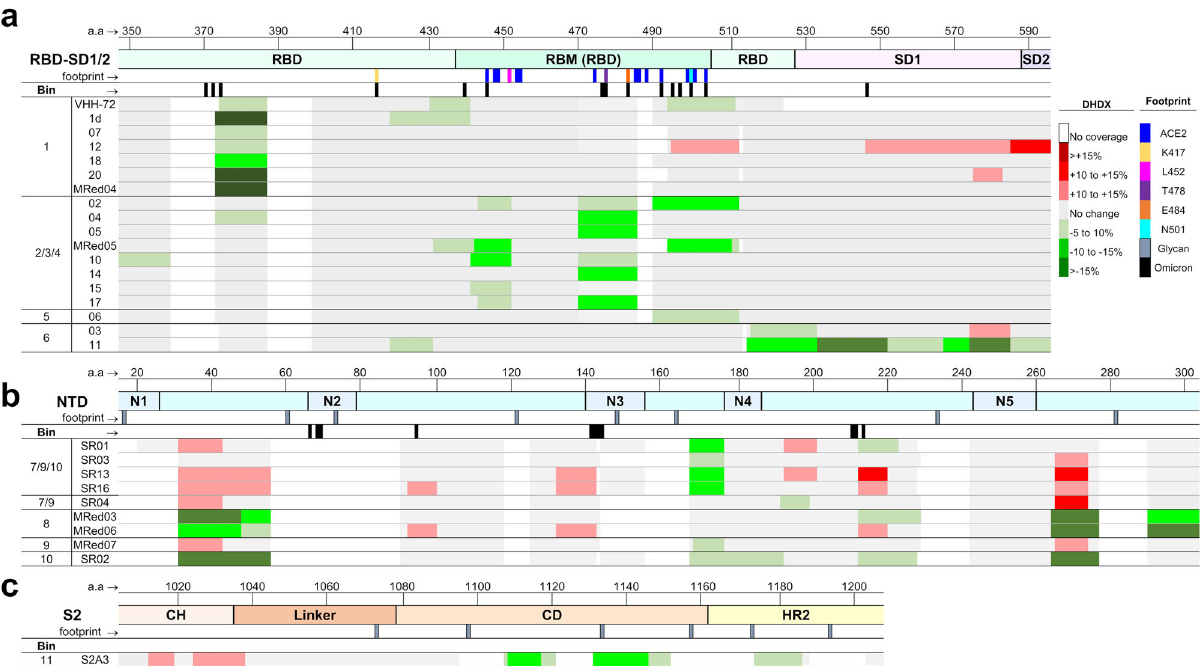
Fig. 5 Epitope mapping. a – c HDX/MS epitope mapping of V H Hs binding RBD ( a ), NTD ( b ) and S2 ( c ). Only relevant S2 residues are shown. Changes in deuteration are mapped as colored rectangles corresponding to primary sequences. Stabilizations are shown in green, and destabilizations are shown in red, while regions with no signi fi cant changes in deuteration are shown in gray and missing coverage in white. Key structural features are highlighted by lines below the amino acid sequence, including the ACE2 binding site (blue), mutations from VoCs, and N-linked glycans are included for reference. Source data used to generate the fi gure are included in Supplementary Data